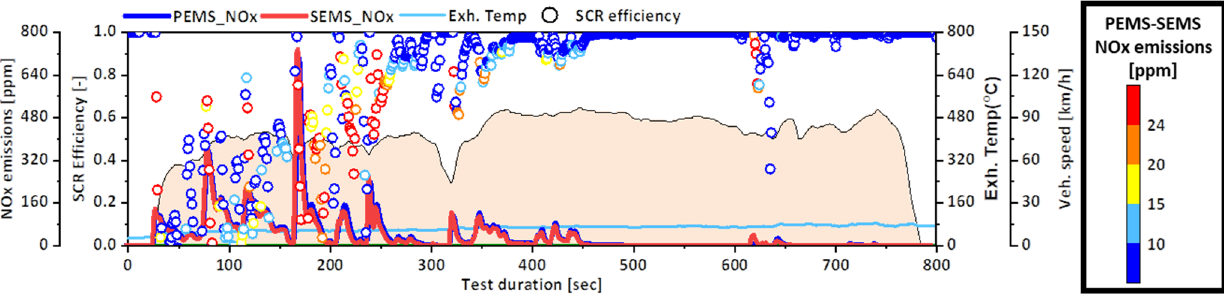
Figure 13. Real-time profiles of SCR efficiency and the difference between NOX emissions measured by the PEMS and SEMS equipment under HWFET test modes in the laboratory .